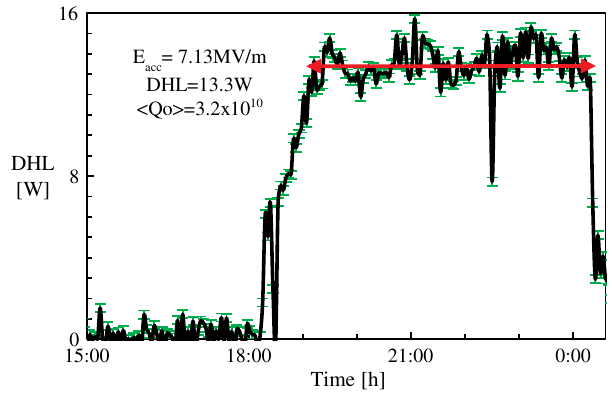
¼ 7 . 13 MV = m at 2 K after second fast acc ¼ 0 MV = m was DHL ¼ 0 ½ W (cid:3) . acc